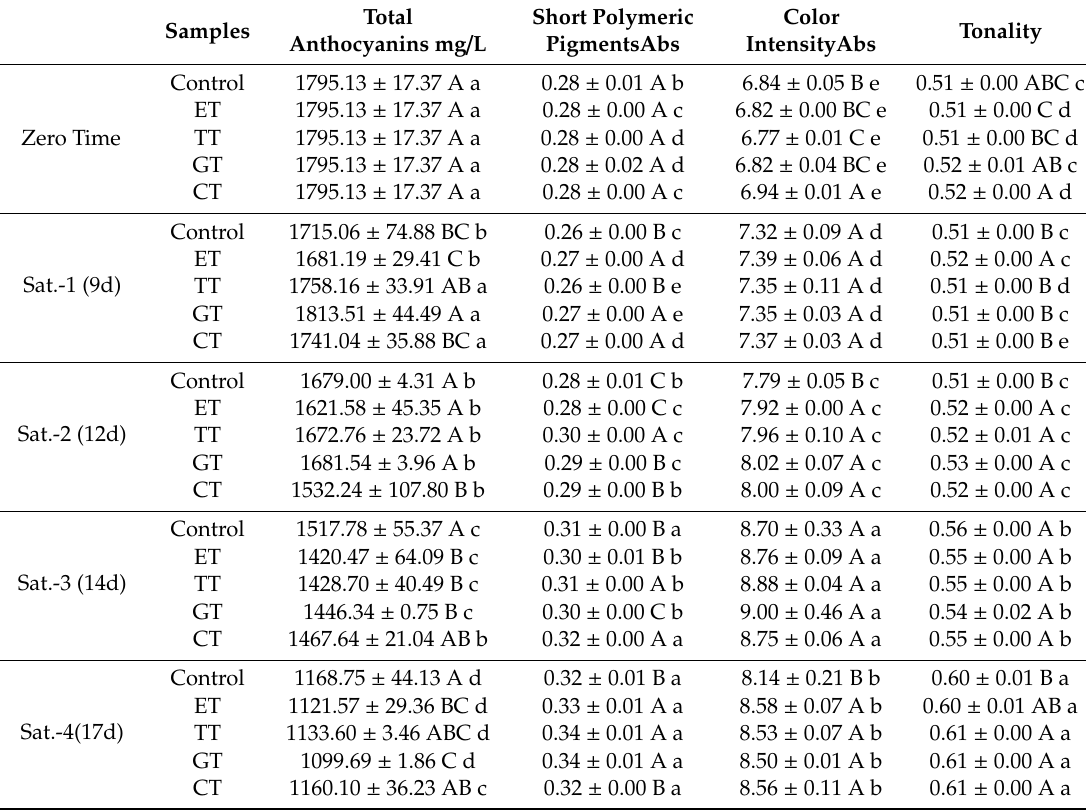
Table 2. Native anthocyanins, polymeric pigments and chromatic characteristics.